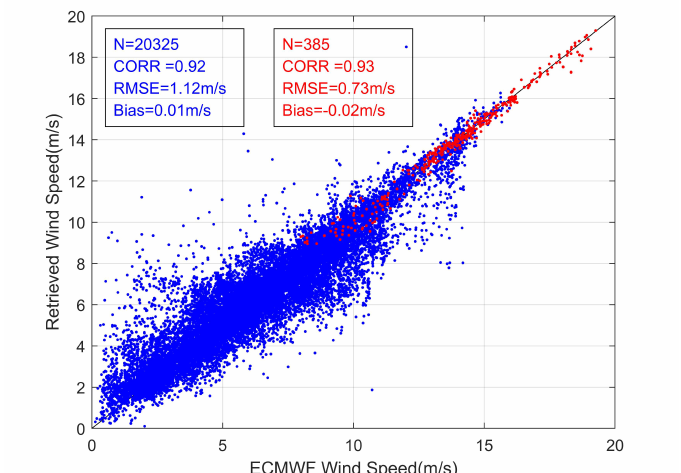
Figure 14. Retrieved wind speeds by the enhanced model with SWH divided into SWHs < 4 m (blue color) and SWHs ≥ 4 m (red color) regions. The black line is ‘y = x’ for